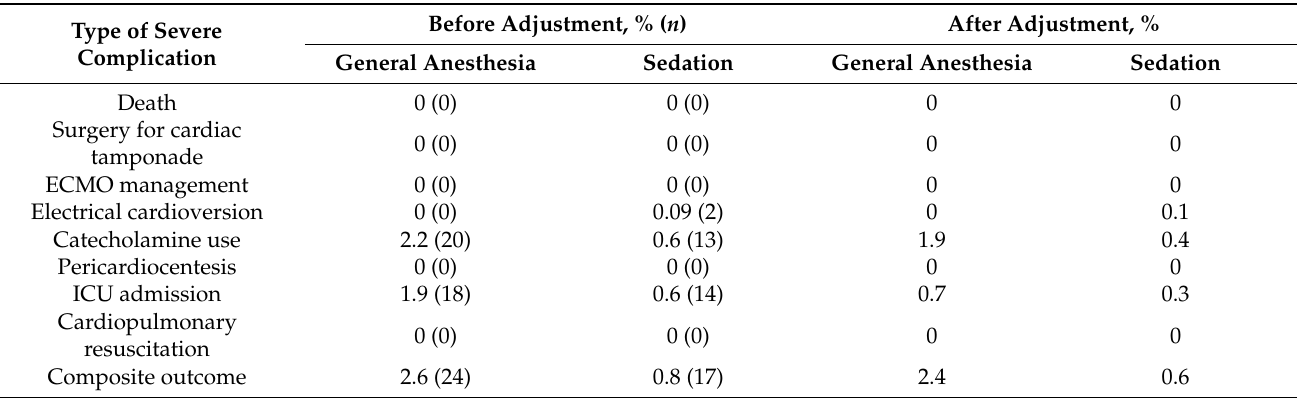
Table 4. Types of severe complications in the general anesthesia and sedation groups, before and after adjustment by overlap weighting using propensity